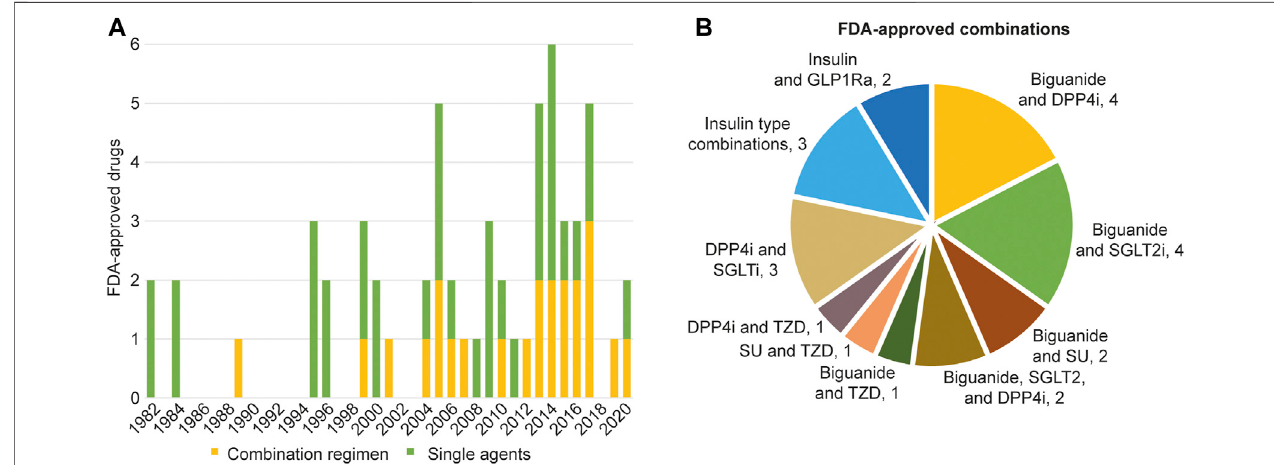
FIGURE 1 | FDA-approved monotherapies and combination regimens. (A) The current 59 FDA-approved anti-diabetic agents. The data includes the year of fi rst approval for new molecular entities and unique combinations. Single agents are indicated in green while combination regimens are in yellow. (B) FDA-approved unique combinations. Data compiled and veri fi ed using the United States Drugs@FDA resource. DPP4i, Dipeptidyl peptidase 4 (DPP4) inhibitor; GLP-1Ra, Glucagon-like peptide-1 (GLP-1) receptor agonist; SGLT2i, Sodium-glucose co-transporter-2 (SGLT2) inhibitor; SU, Sulfonylureas; TZD, Thiazolinediones.